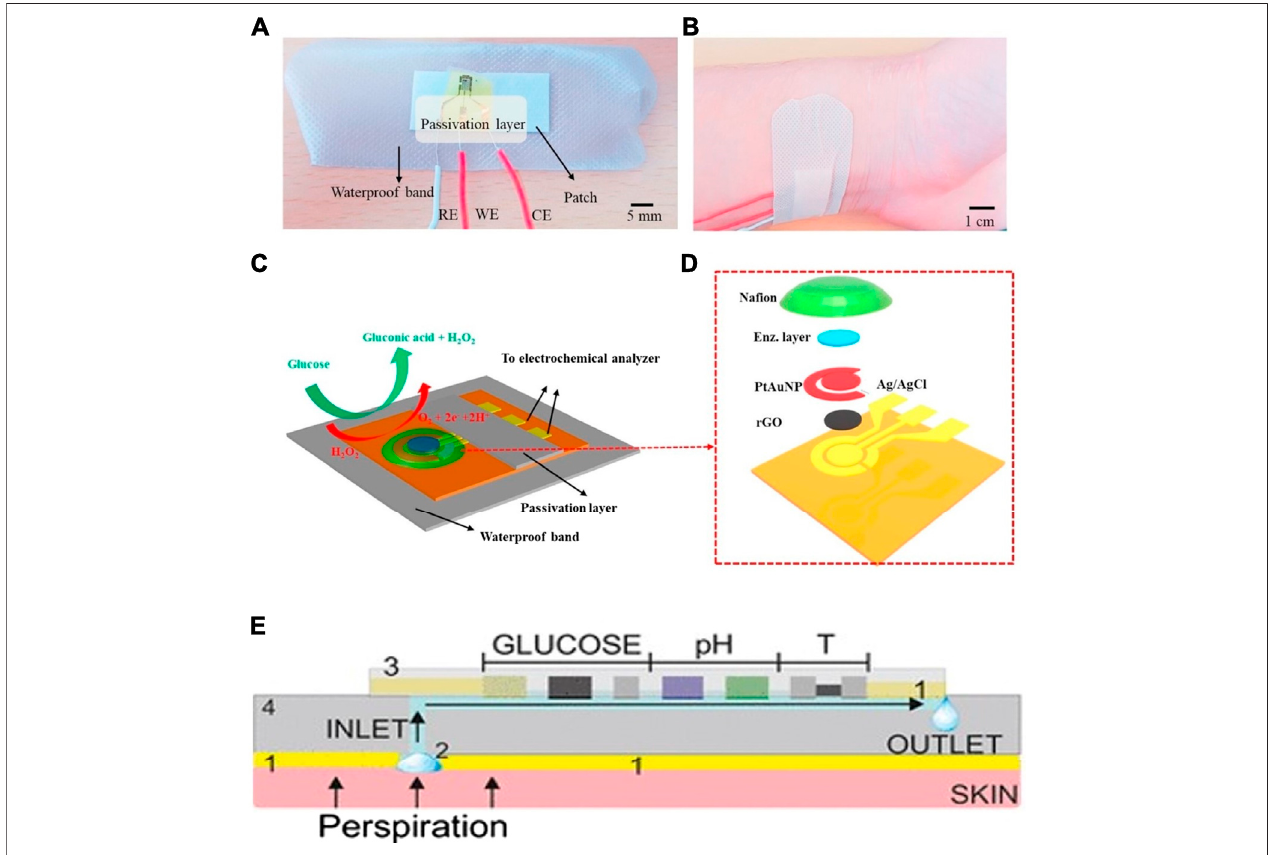
FIGURE5| Schematicsandmechanismofsweat-basedCGMs. (A,B) Structureofthesensorandthesketchforthedeviceapplyingontheskin(Xuanetal.,2018). (C,D) The reaction mechanism and the exploded view for the sensor (Xuan et al., 2018). (E) optimization of the device, minimum the temperature and PH impact on the result (Wiorek et al.,